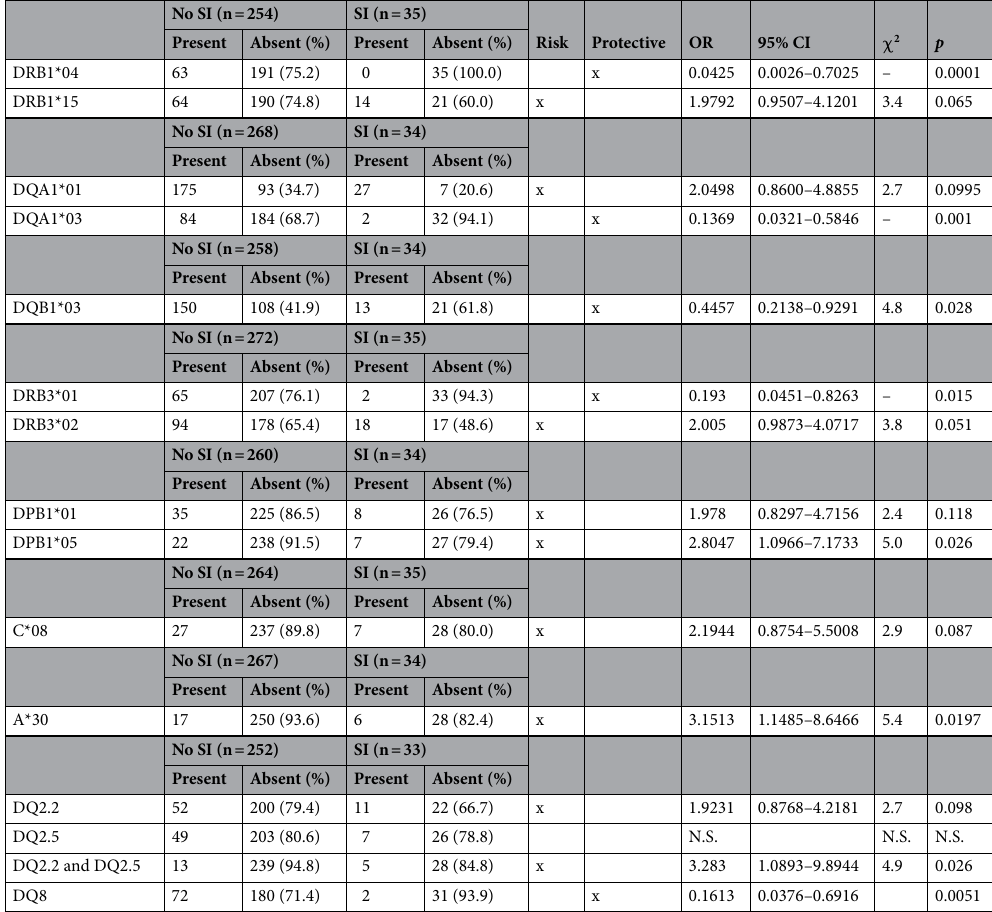
Table 2. Human Leukocyte Antigen (HLA) haplotypes associated with incidence of suicidal ideation (SI). χ 2 and odds ratio (OR) results for HLA haplotypes that were near or significant. Fisher exact test was computed where χ 2 is not listed. Risk indicators associate with increased incidence of SI, while protective factors associate with decreased